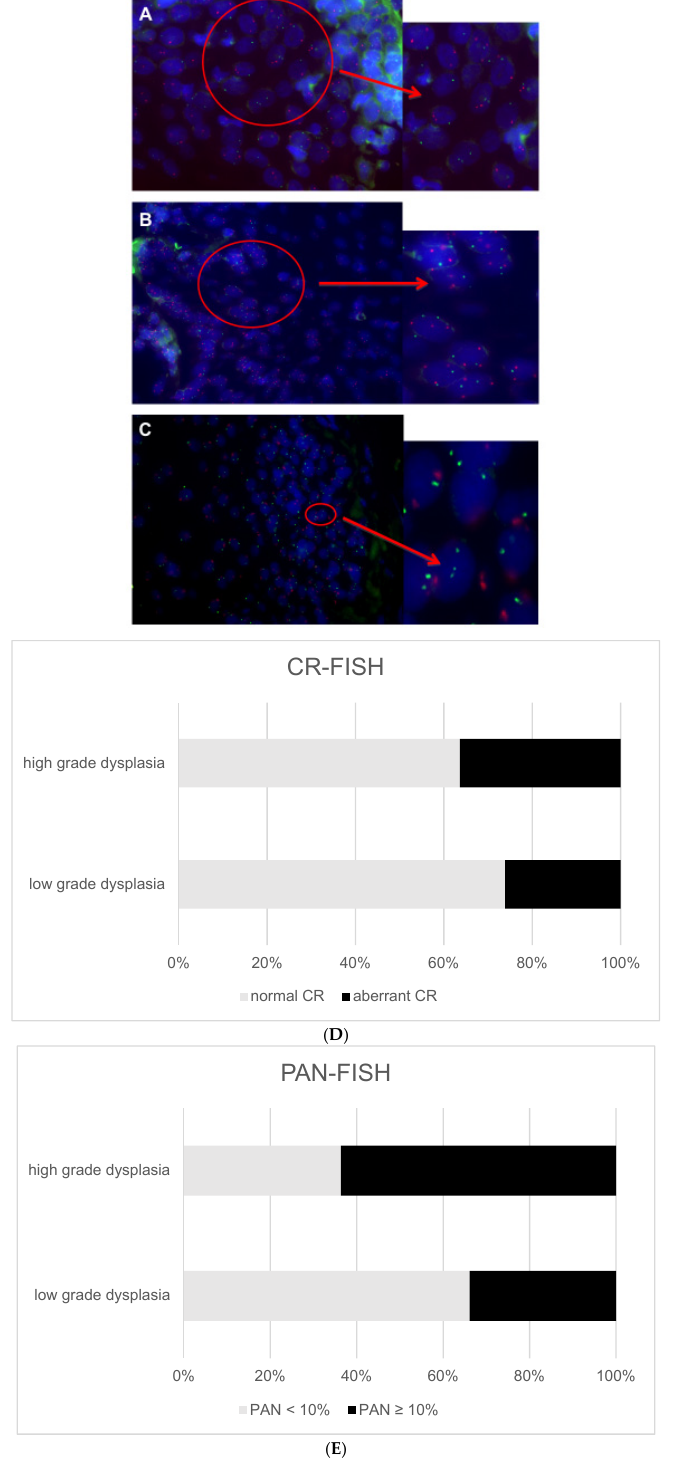
Figure 1. ( A – C ) Representative images of tissue sections of premalignant laryngeal lesions, analyzed by FISH 1/7 with centromere probes for chromosome instability (CI) detection showing disomy for chromosomes 1 (green) and 7 (red) (no CI) ( A ), trisomy for chromosome 1, and polysomy for chromosome 7 (CI) resulting in an aberrant CR and PAN ≥ 10% ( B ) and a lesion with only few aberrant nuclei, resulting in a normal CR but PAN ≥ 10% ( C ). ( D , E ) Percentage of CI in premalignant laryngeal lesions (low-grade dysplasia versus high-grade dysplasia) CR-FISH ( D ) and PAN-FISH ( E ). (b) Assessment of CR-FISH in premalignant laryngeal lesions and the association with malignant progression. CR-FISH analysis indicated aberrant CR in 25 of the 87 lesions. In most cases (21 out of 25; 84%) we found a CR ≥ 1.16 indicating a relative gain for chromosome 7, which is in agreement with previous studies [20]. A representative image of a premalignant lesion with an aberrant CR is displayed in Figure 1B. Aberrant CRs were found in both low-grade and high-grade dysplasia, which demonstrates that the morphology of premalignant laryngeal lesions does not reflect